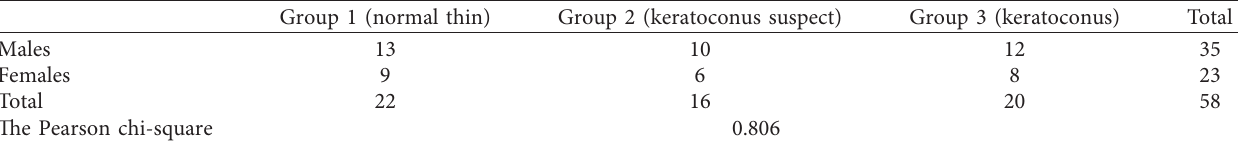
Table 2: Gender distribution in both groups.